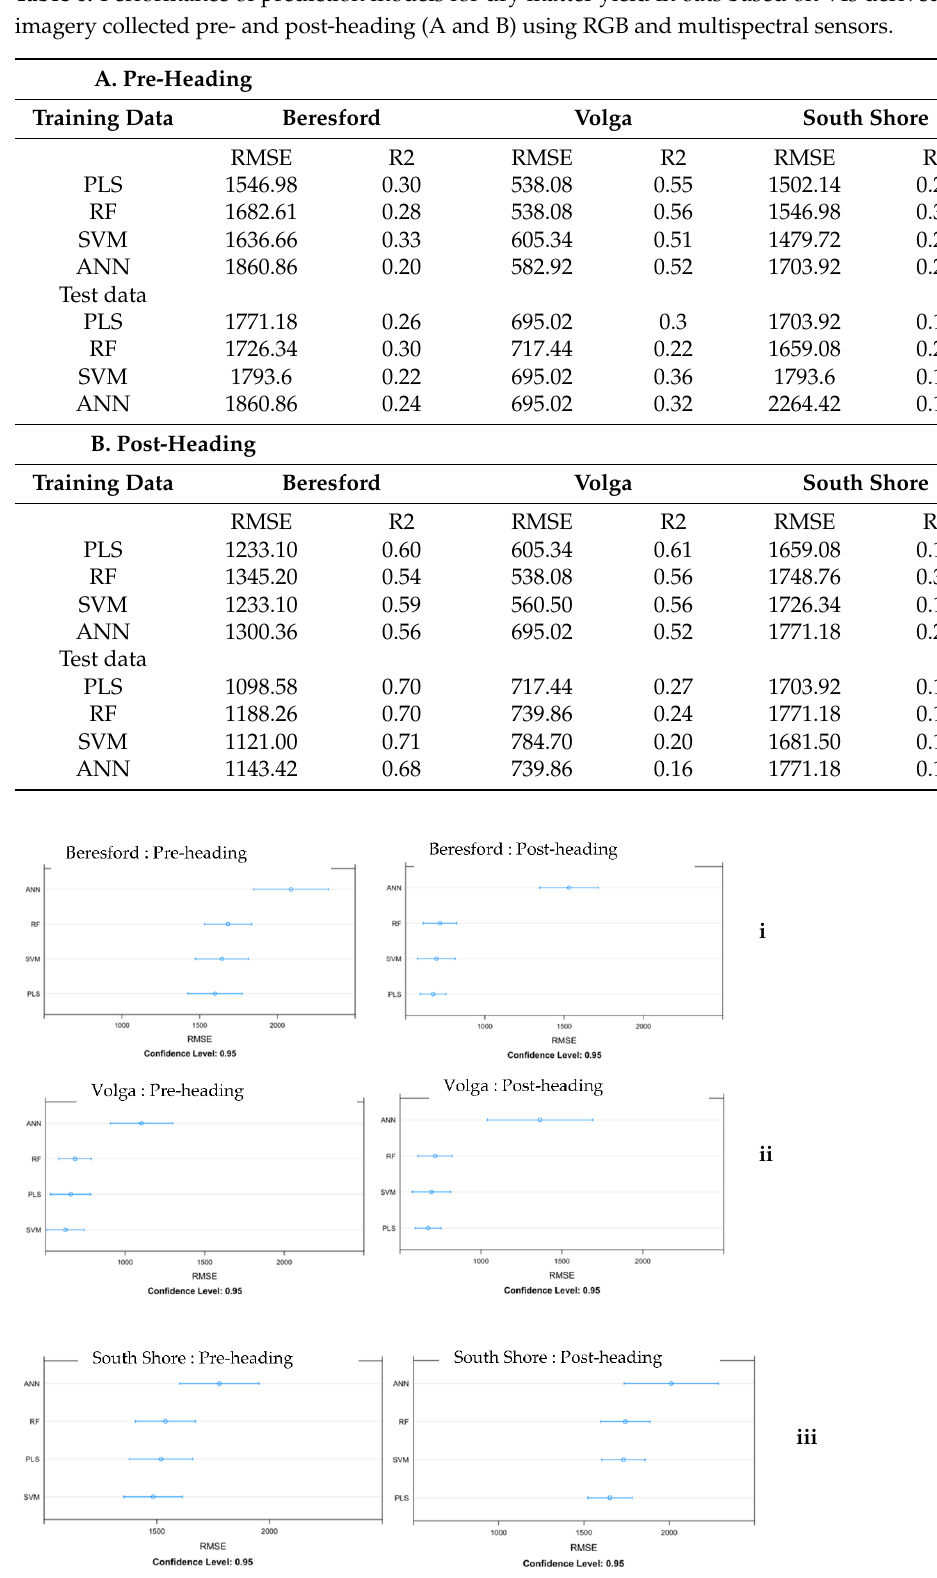
Figure 9. Dot plots from “caret” package show model comparisons using the resampling technique for Beresford ( i) , Volga ( ii ), and South Shore ( iii ). Each plot shows the mean estimated RMSE value for all four algorithms. Error bars are 95% confidence intervals on the metrics for each algorithm.